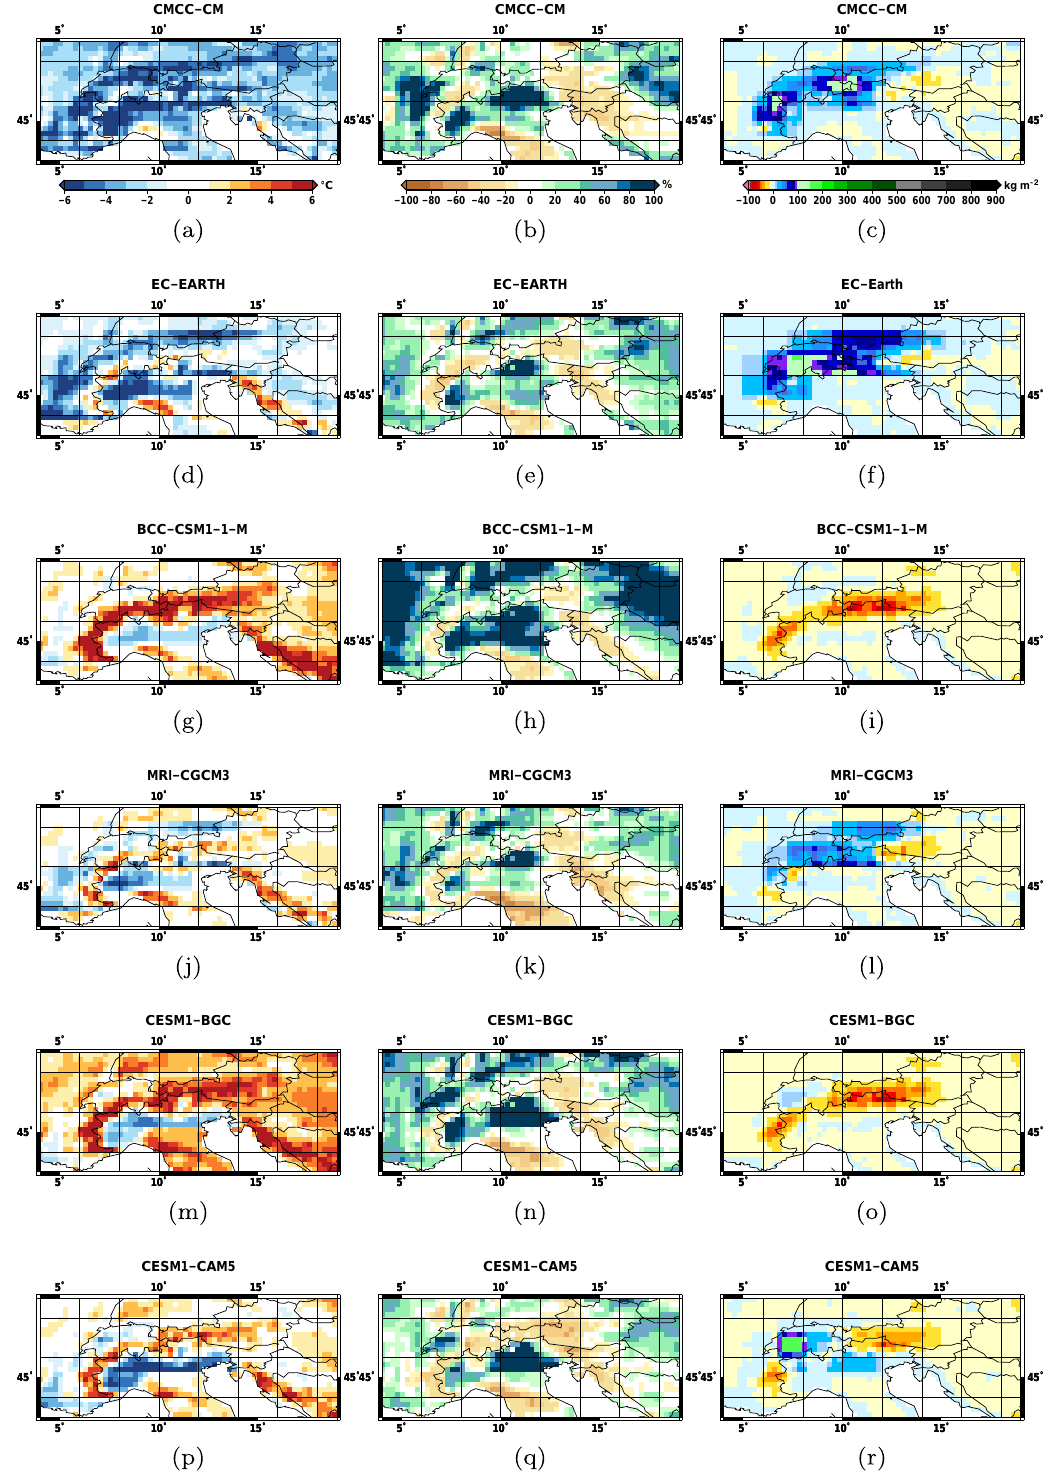
Figure 3. DJFMA (first column) air temperature, (second column) total precipitation and (third column) snow water equivalent biases of the CMIP5 global climate models with spatial resolution equal to or finer than 1.25 ◦ longitude with respect to the EOBS and NSIDC-SNW climatologies reported in Fig. 2a, b,